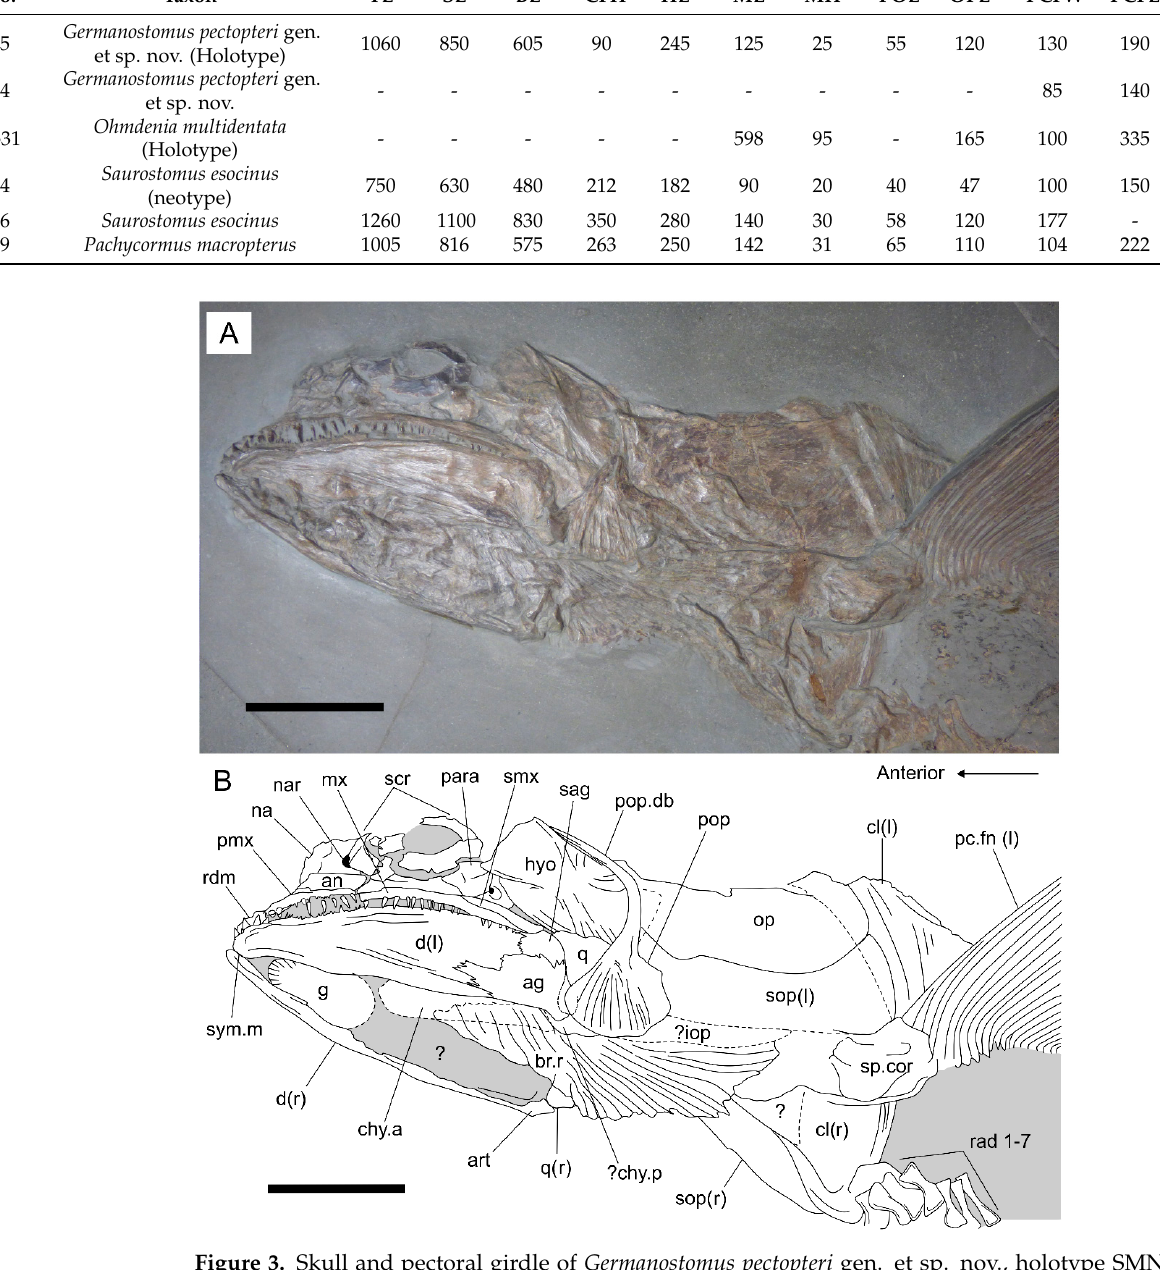
Figure 3. Skull and pectoral girdle of Germanostomus pectopteri gen. et sp. nov., holotype SMNS 15815: ( A ) skull in left lateroventral view; ( B ) annotated line drawing. ag, angular; an, antorbital; art, articular; br.r, branchiostegal rays; chy.a, anterior ceratohyal; chy.p, posterior ceratohyal; cl, cleithrum (l, left; r, right); d, dentary; g, gular; hyo, hyomandibula; ?iop, interopercle; mx, maxilla; na, nasal; nar, (?anterior) naris; op, opercle; para, parasphenoid; pc.fn, pectoral fin; pmx, premaxilla; pop, preopercle; pop.db, dorsal branch of the preopercle; q, quadrate; rad 1–7, radials 1–7; rdm, rosterodermethmoid; sag, surangular; scr, sclerotic ring; smx, supramaxilla; sop, subopercle; sp.cor, scapulocoracoid; sym.m, mandibular symphysis. Scale bars = 50 mm.